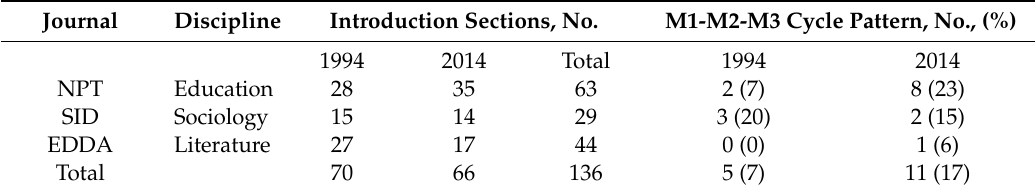
Table 4. Number and percentages of introductions following an M1-M2-M3 pattern.